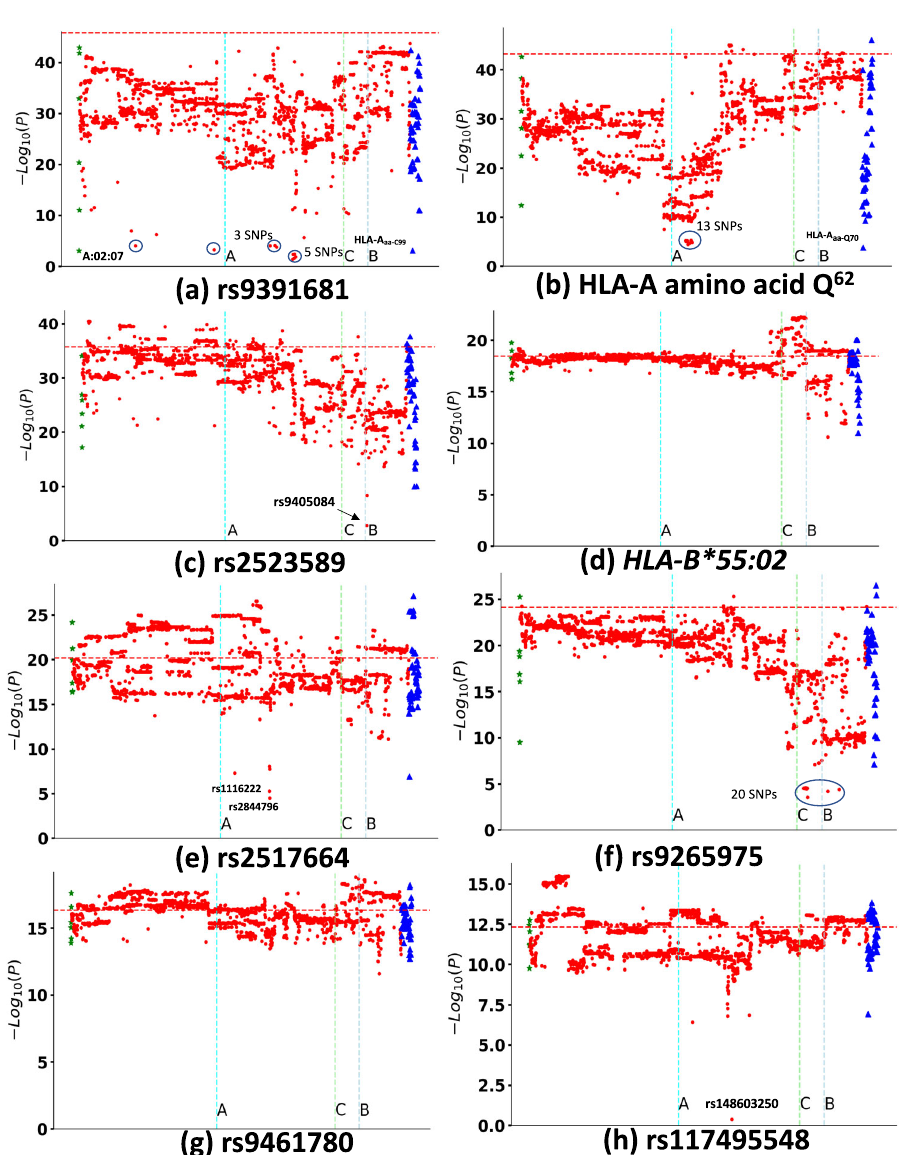
Fig. 2 Proxy variant analysis for the eight independent variants adjusted for age and gender. Linkage disequilibrium-proxies reduce markedly the − log 10 ( P ) of the index variants a rs9391681, b HLA-A aa-Q62 , c rs2523589, d HLA-B*55:02 , e rs2517664, f rs9265975, g rs9461780, h rs117495548. Signi fi cantly reduced SNPs are circled. (Details in Supplementary Data 1 for 2967 variants after controlling the eight index variants.) Conditional logistic regression analysis reveals the residual association effect of eight independent signals after adjustment with 2967 signi fi cant variants, which includes 2899 SNPs/Indels (red dots), 62 amino acid variants (blue triangles), and 6 HLA alleles (green stars). The X axis shows the covariant and the Y axis shows the adjusted − log 10 ( P ) for the independent variants. The horizontal red dotted line indicates the unadjusted − log 10 ( P ) of the index variant. SNPs were sorted according to chromosomal coordinates and vertical light blue, green, and gray dotted lines show the location of HLA-A/B/C